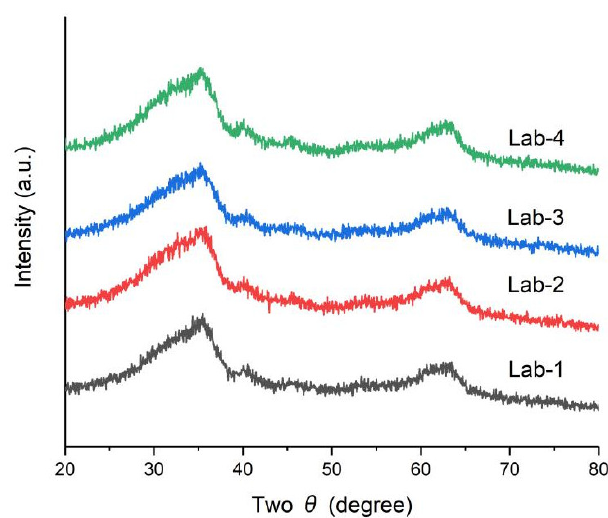
Figure 1. XRD pattern of the calcined precursor samples.